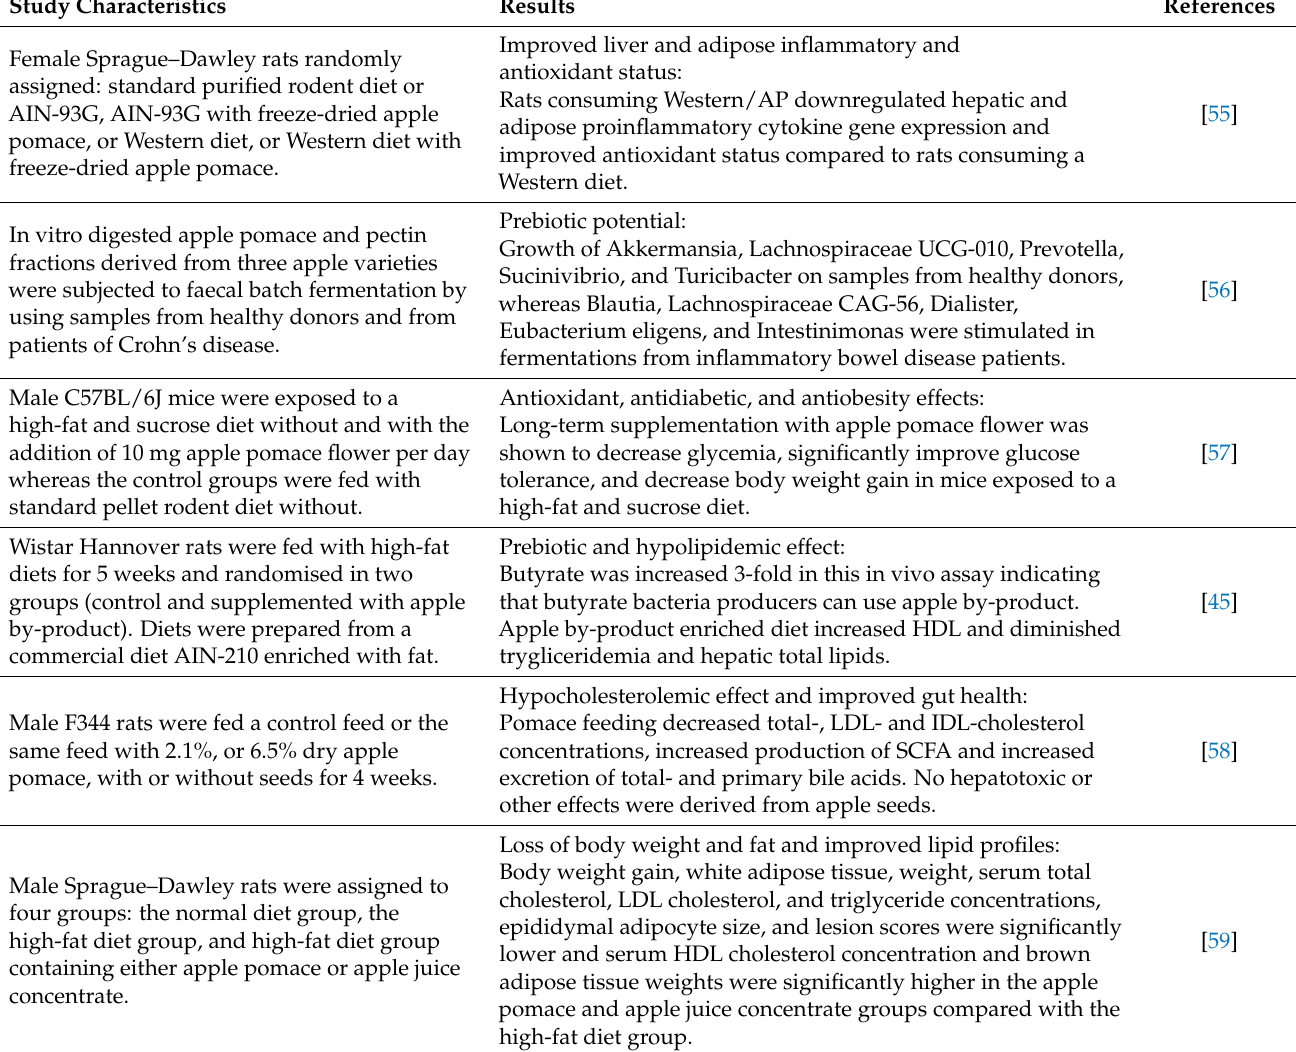
Table 2. Revision of the studies of the effects of the apple by-product on health. Study Characteristics